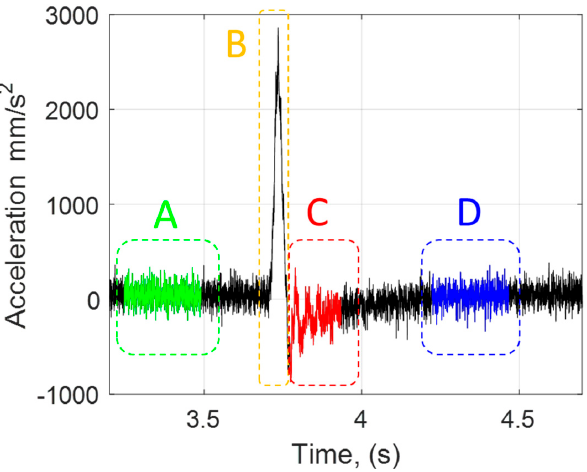
Figure 9. Raw vibrations of the high Acc/Dec experiment. (The period A, B, C and D were marked as in Figure 7, respectively.)